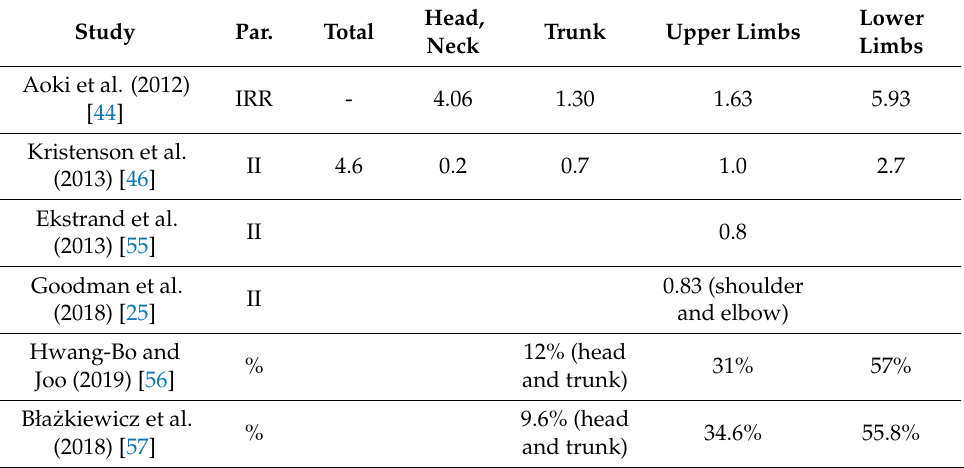
Table 2. Injuries location—results by different